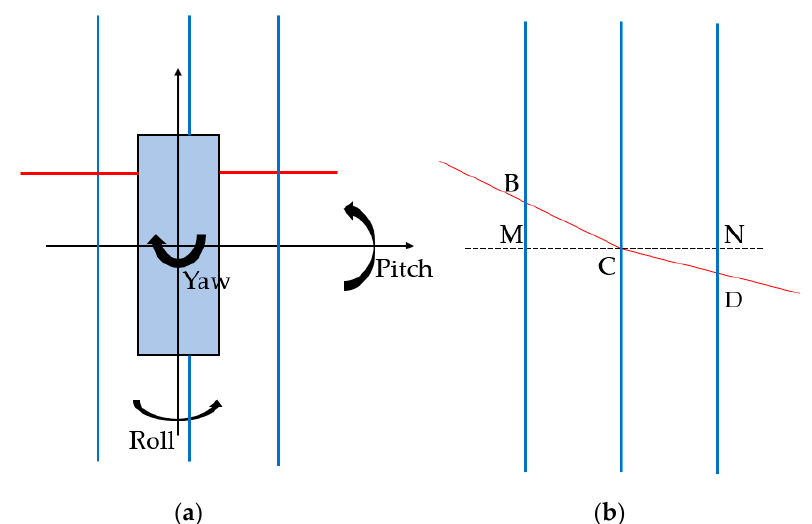
Figure 7. Illustration of 3D posture calibration of structured light sensors: ( a ) top view; ( b ) schematic diagram.